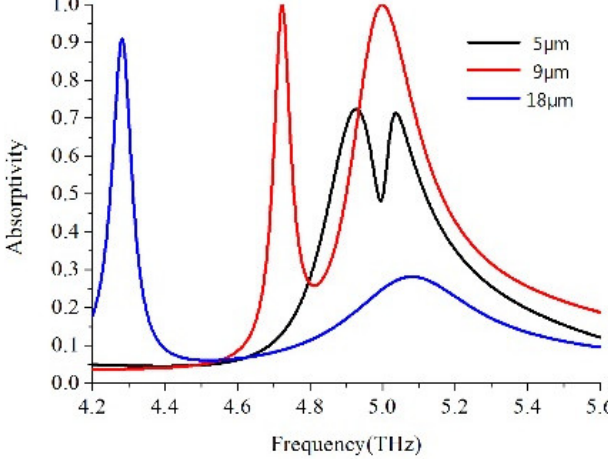
Figure 2. Simulated absorptivity for the symmetric H-shaped unit cell with ∆ x = 18 µ m and asymmetric H-shaped unit cell with ∆ x = 5 and 9 µ m.